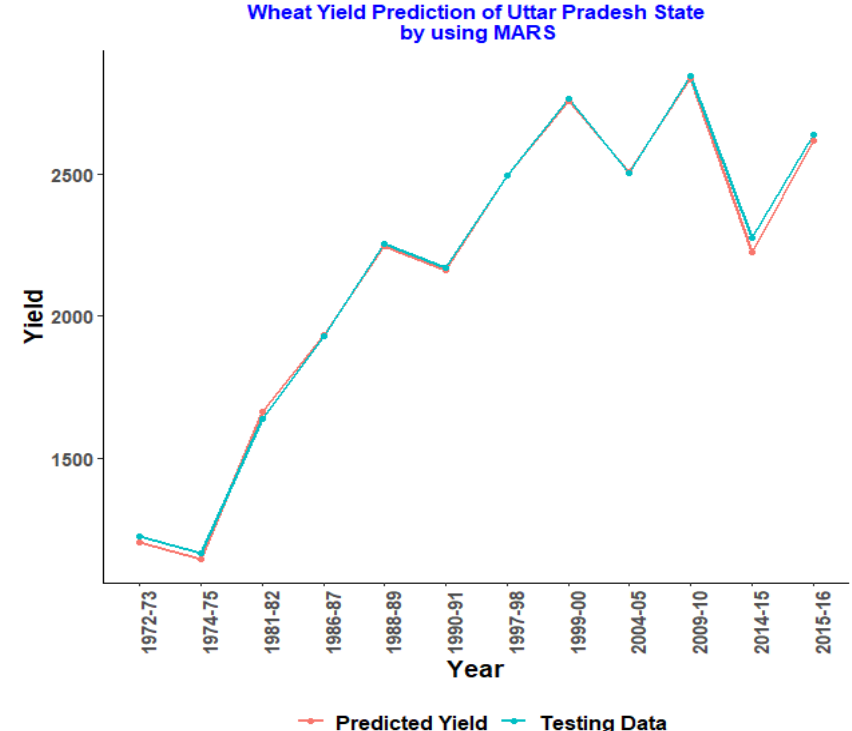
Figure 5. MARS model for Uttar Pradesh.